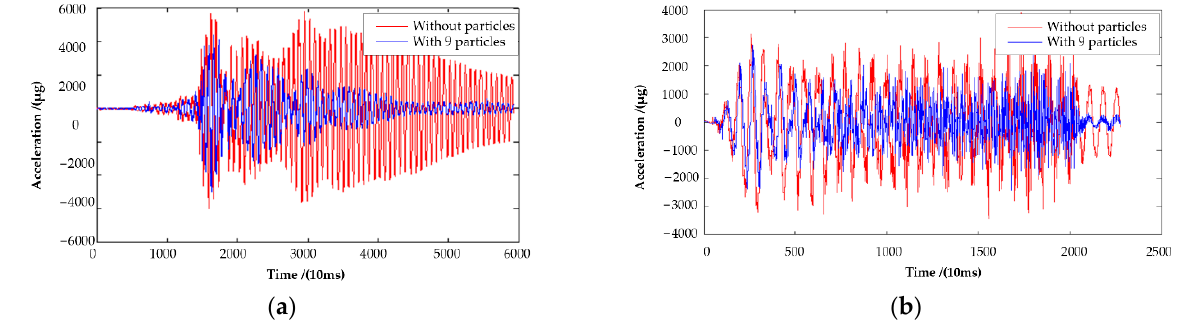
Figure 5. Acceleration responses of 1% mass ratio between TLD (without particles) and PDAL (with 9 particles): ( a ) Kobe wave; ( b ) sine sweep wave.